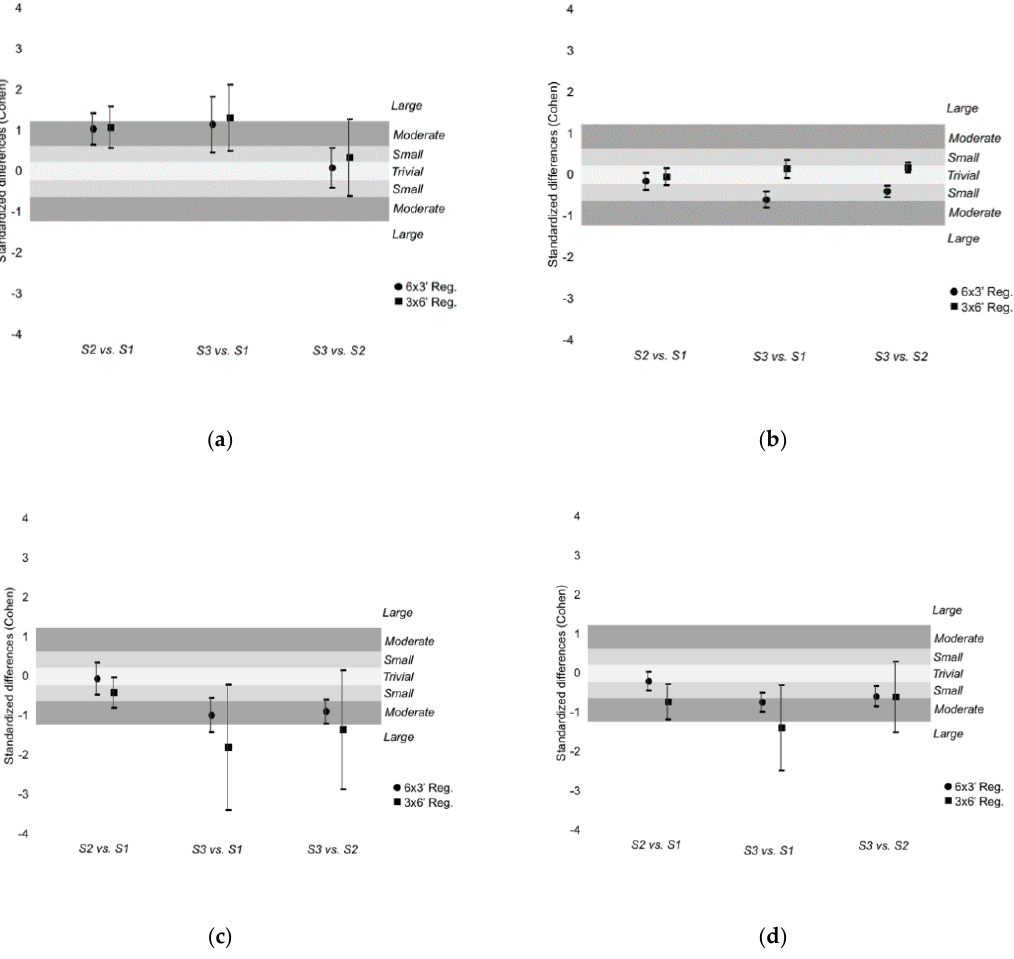
Figure 1. Standardized di ff erence (Cohen) between sets in ( a ) RPE; ( b ) HRmean; ( c ) Total Distance; and ( d ) Player Load. The six sets of the 6 × 3 ’ regimen were grouped in three sets (S1: mean of set 1 and 2; S2: mean of set 3 and 4; S3: mean of set 5 and 6) to a better visualization and analysis. Standardized value direction depends on the relationship A-B.